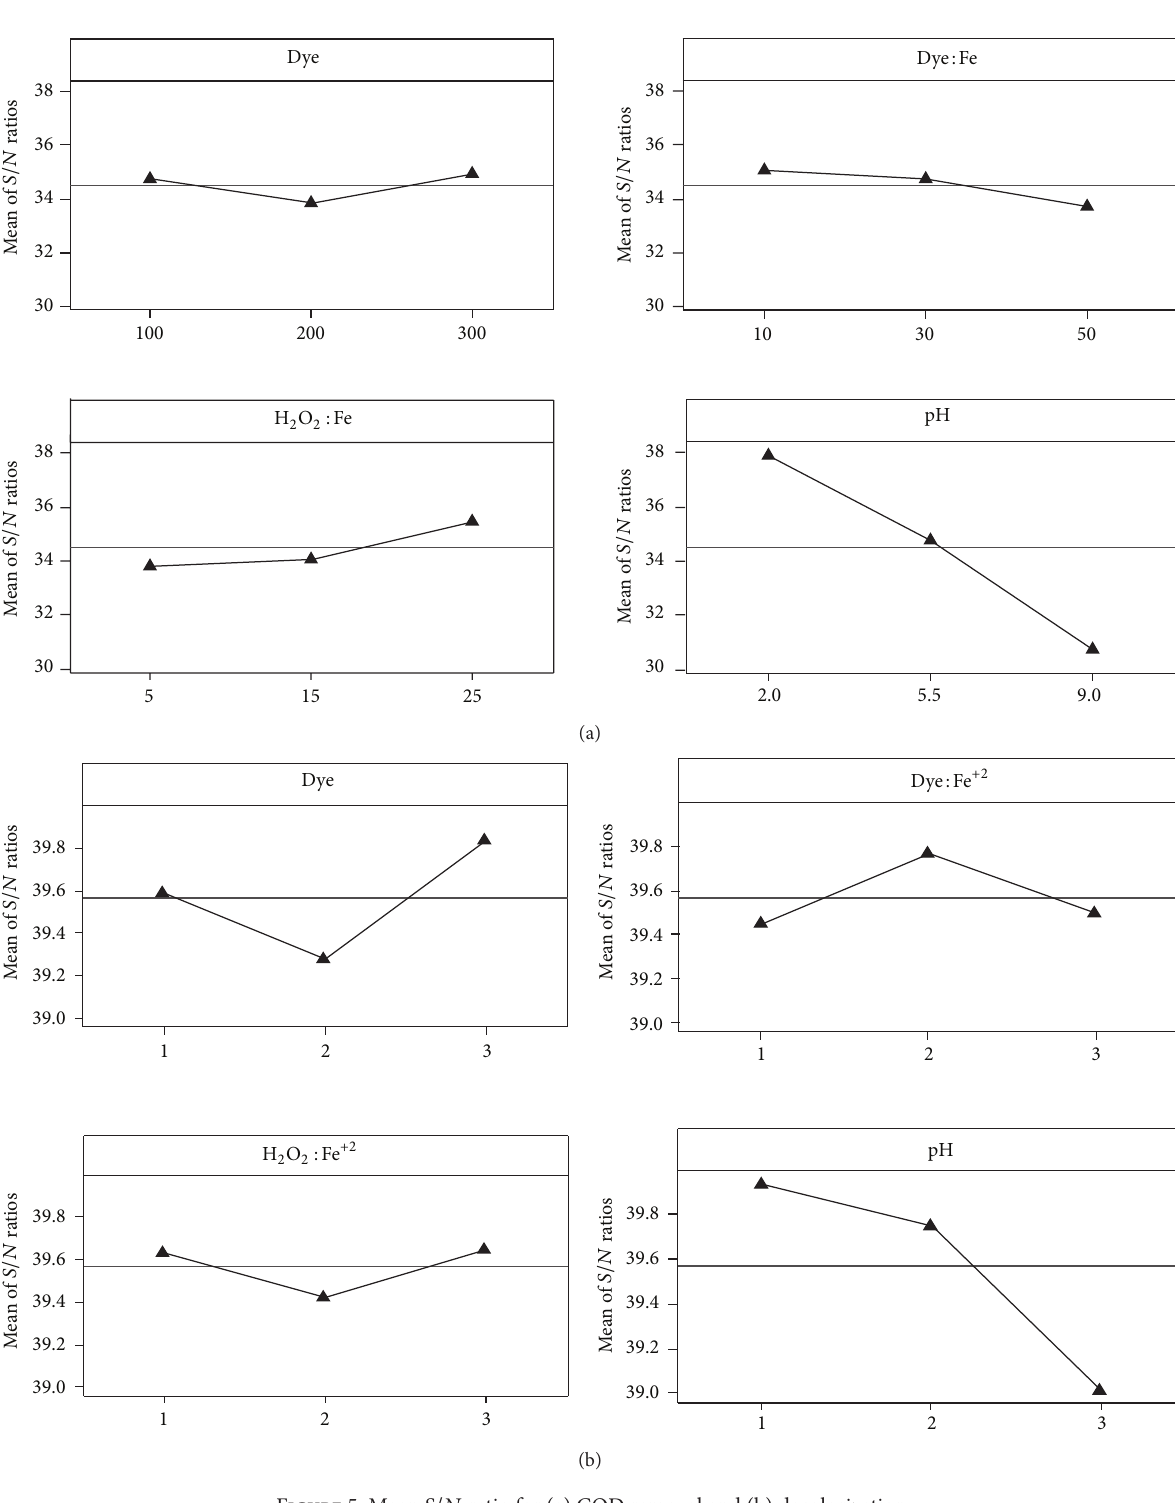
Figure 5: Mean 𝑆/𝑁 ratio for (a) COD removal and (b) decolorization. Table 10: Optimized values for COD removal and